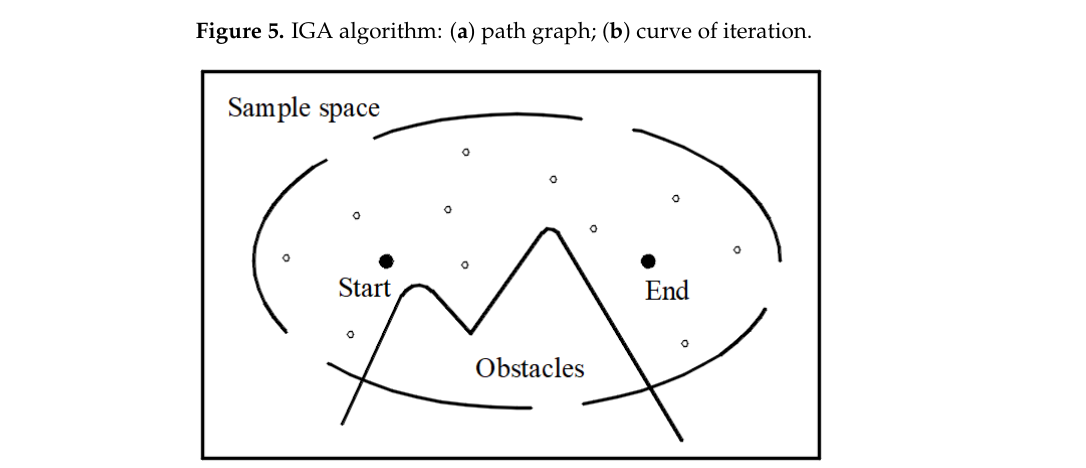
Figure 6. Optimized sampling space.